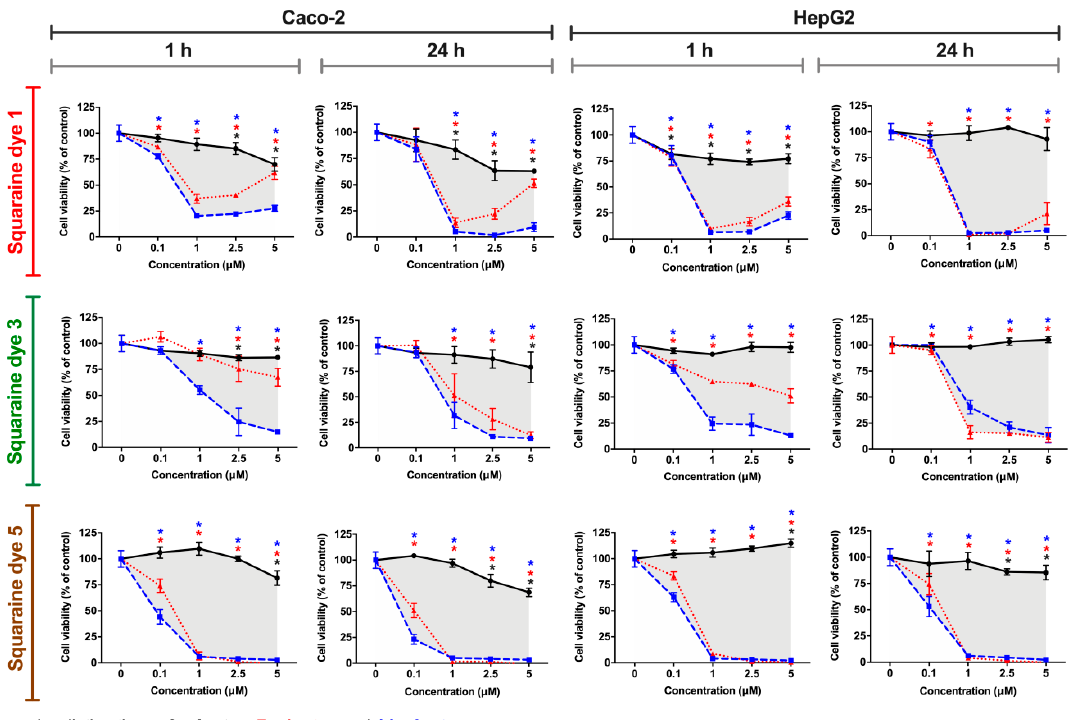
Figure 6. Photodynamic e ff ects of dicyanomethylene squaraine dyes 1 , 3 and 5 on Caco-2 (human colorectal adenocarcinoma) and HepG2 (human hepatocellular carcinoma) cells. After cells’ incubation for 24 h with the respective dye (at 0.1, 1, 2.5 and 5 µ M), cells were irradiated with suitable light-emitting diode systems for 0, 7, and 14 min (black, red and blue lines, respectively). After irradiation, the cells were maintained in contact with the irradiated dyes for 1 h or 24 h, and Alamar Blue reduction assay was performed for cell viability assessment. Results are expressed as % of control, non-treated cells, and presented as mean ± standard error of the mean (n = 3 independent experiments; each experiment in quadruplicates). Conditions with statistical significance compared to the negative control ( p -value < 0.05) are indicated by an asterisk (*) of the color relative to the irradiation time. The shaded area delimits the di ff erence in the percentage of cell viability between treatment with and without irradiation.